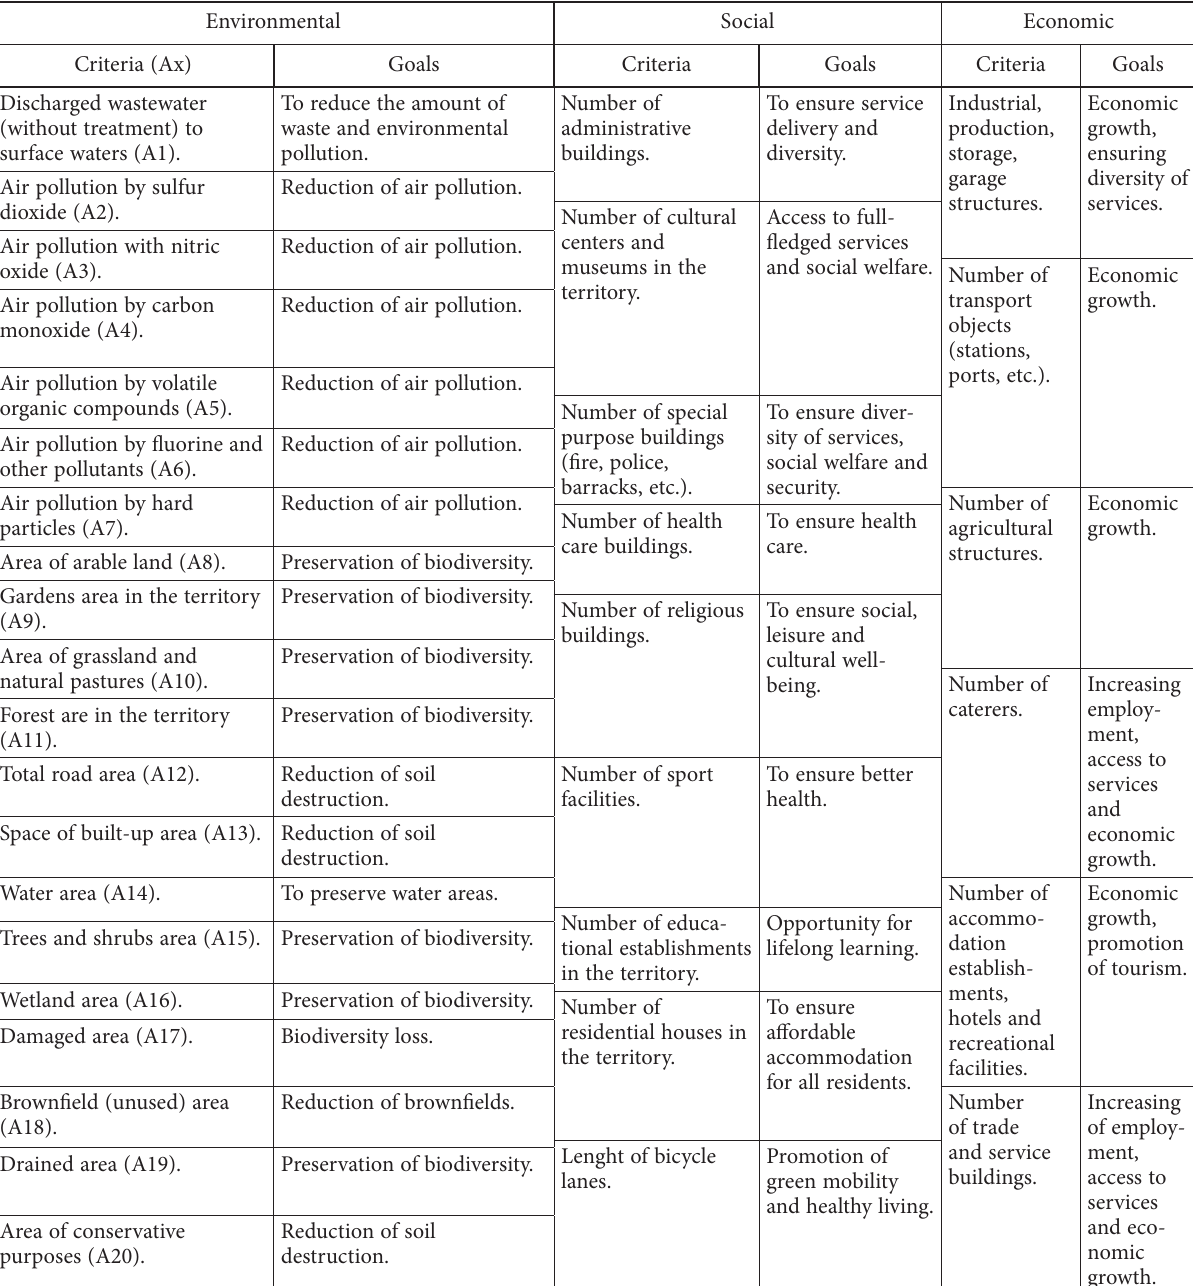
Table 2. ALOL Index Criteria (source: prepared by the